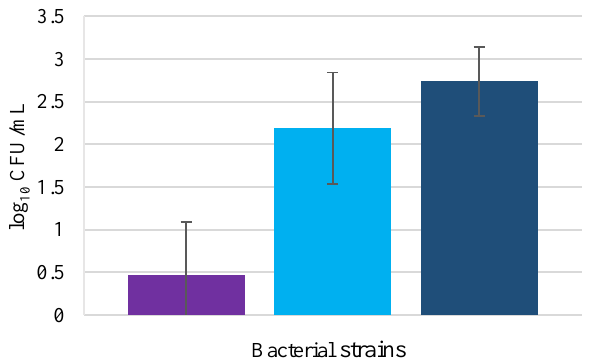
Figure 1. Pathogenic bacteria invasion of HaCat cells; Escherichia coli ( ■ ), Pseudomonas aeruginosa ( ■ ), and Staphylococcus aureus ( ■ ). Error bars are ± standard deviation.